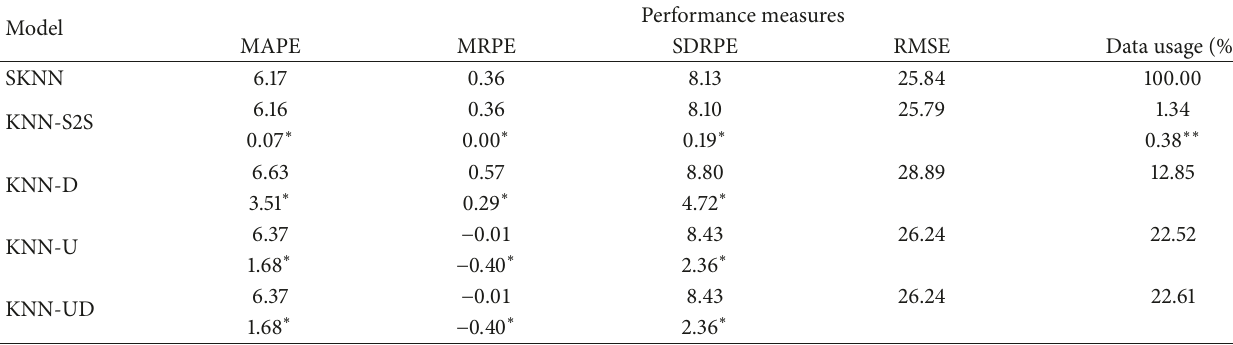
Table 1: Summary of the analysis results.